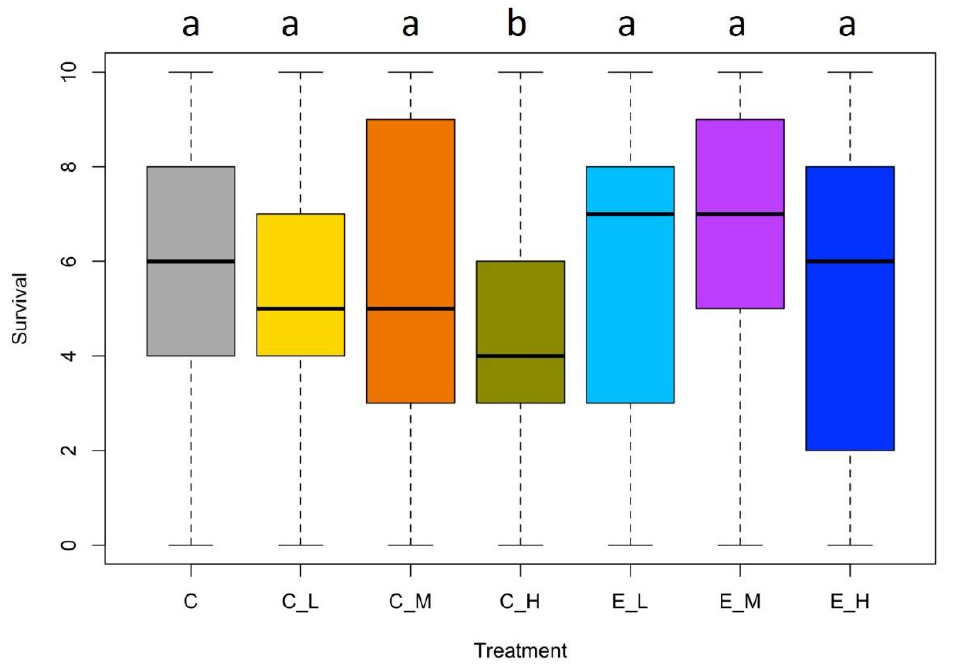
Figure 2. Survival analysis of Nectopsyche sp. related by different concentrations of Chlorpyrifos (C_ L: Low, C_M: Middle; C_H: High) and Engeo (E_L: Low, E_M: Middle; E_H: High). C corresponds to the experimental control. The letters on the box plots correspond to significant differences in the Tukey test between treatments and the control, no shared letters show significant differences.